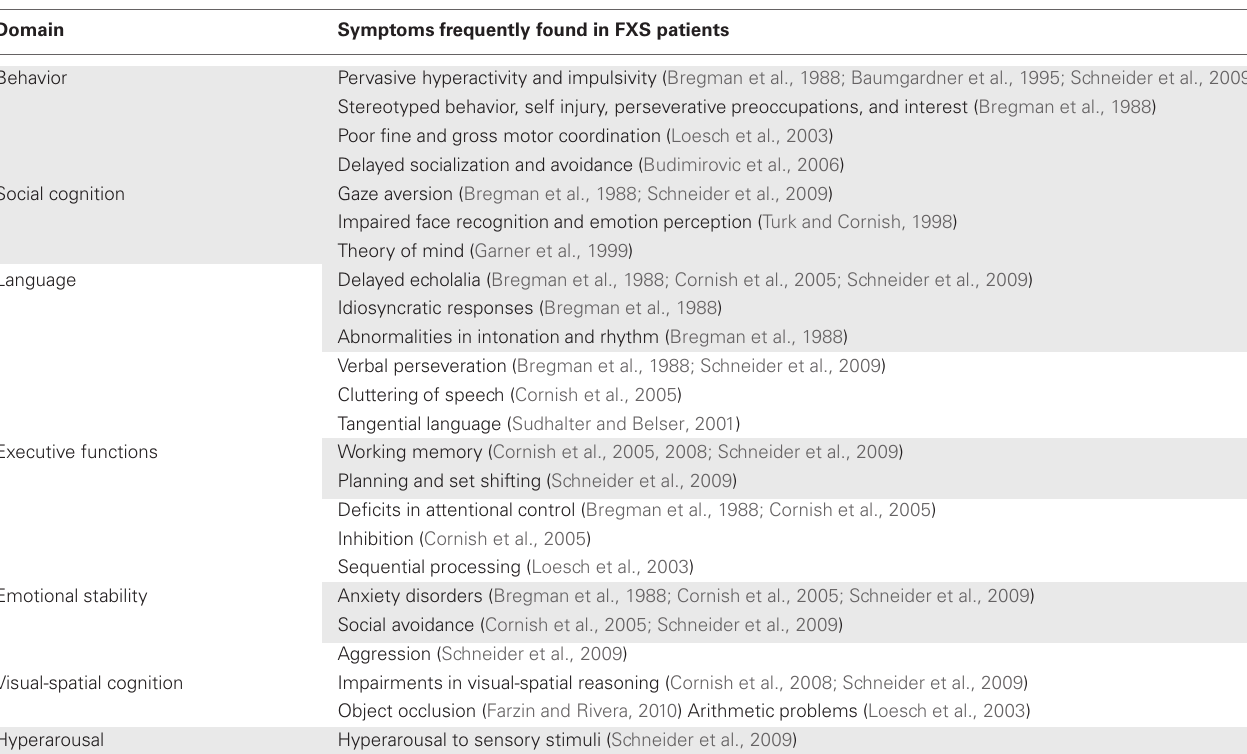
Table 1 | Symptoms frequently found in FXS patients sorted by